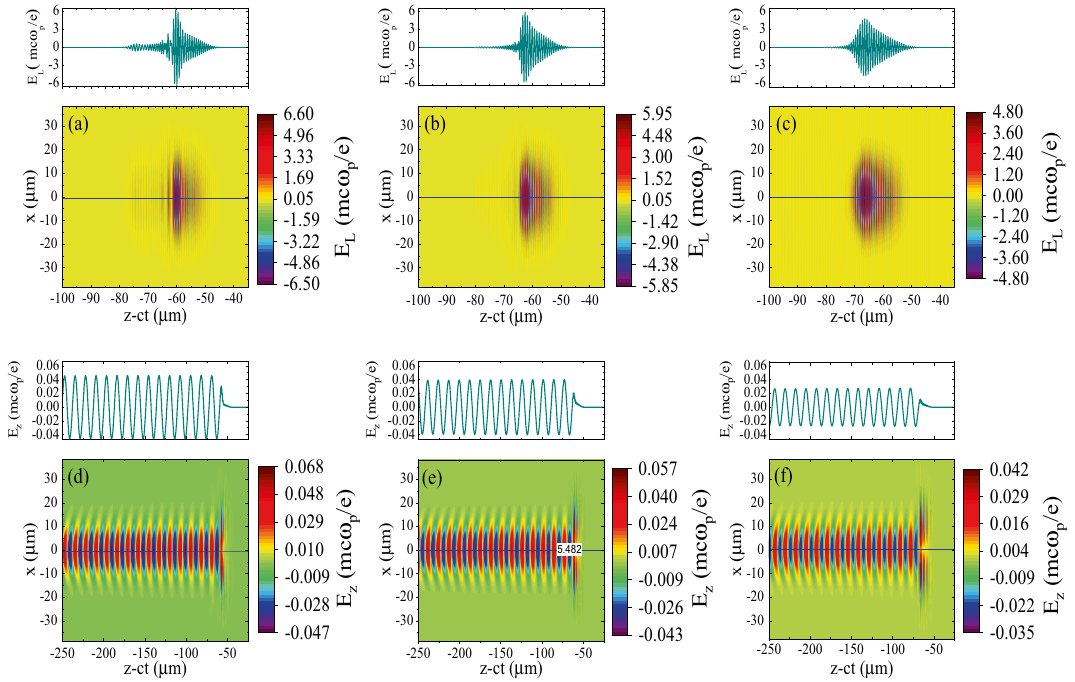
Figure 7. ( a – c ) show the transverse field of the laser pulses, E L , along with the horizontal on-axis line-outs for ( a ) the pulse with positive skew, ( b ) the symmetric pulse, and ( c ) the pulse with negative skew, at the time t = 40 ps; ( d – f ) show the corresponding wakefields along with the horizontal on-axis line-outs. Each pulse initially has a peak amplitude of a 0 = 0.25 , with a duration of 30 fs, and a spot size of w 0 = 15